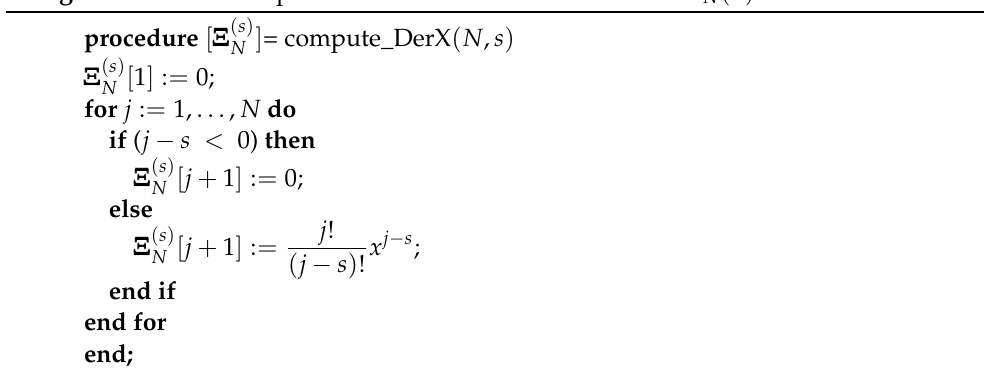
Algorithm 1: The computation of s -derivative of the vector ΞΞΞ N ( x )